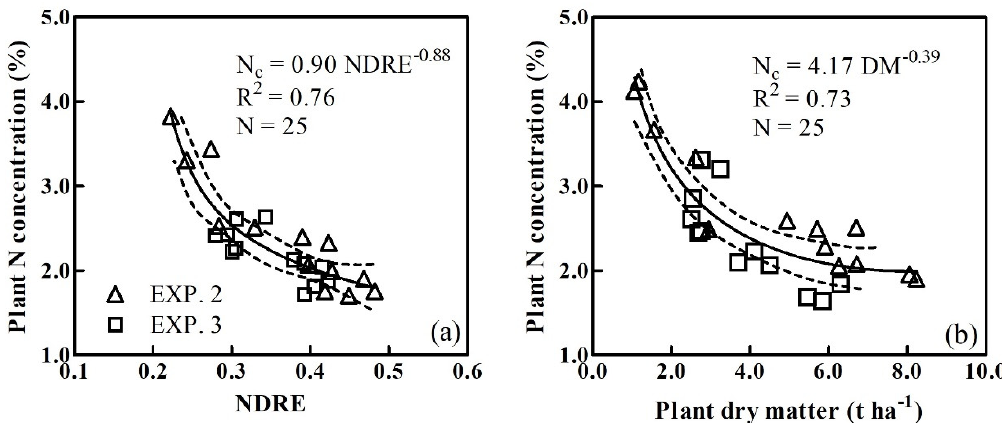
Figure 5. Critical N dilution curves derived from NDRE ( a ) and PDM ( b ). Dotted lines indicate 95% confidence intervals.